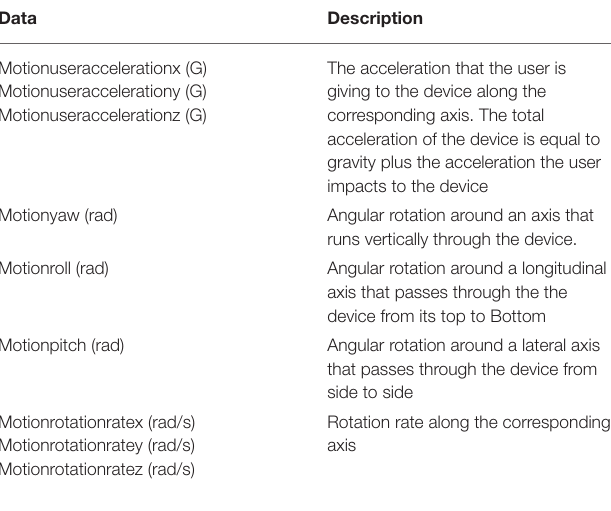
TABLE 1 | The nine channels of data streams used in this research, which can be accessed by the APIs of CoreMotion. Data